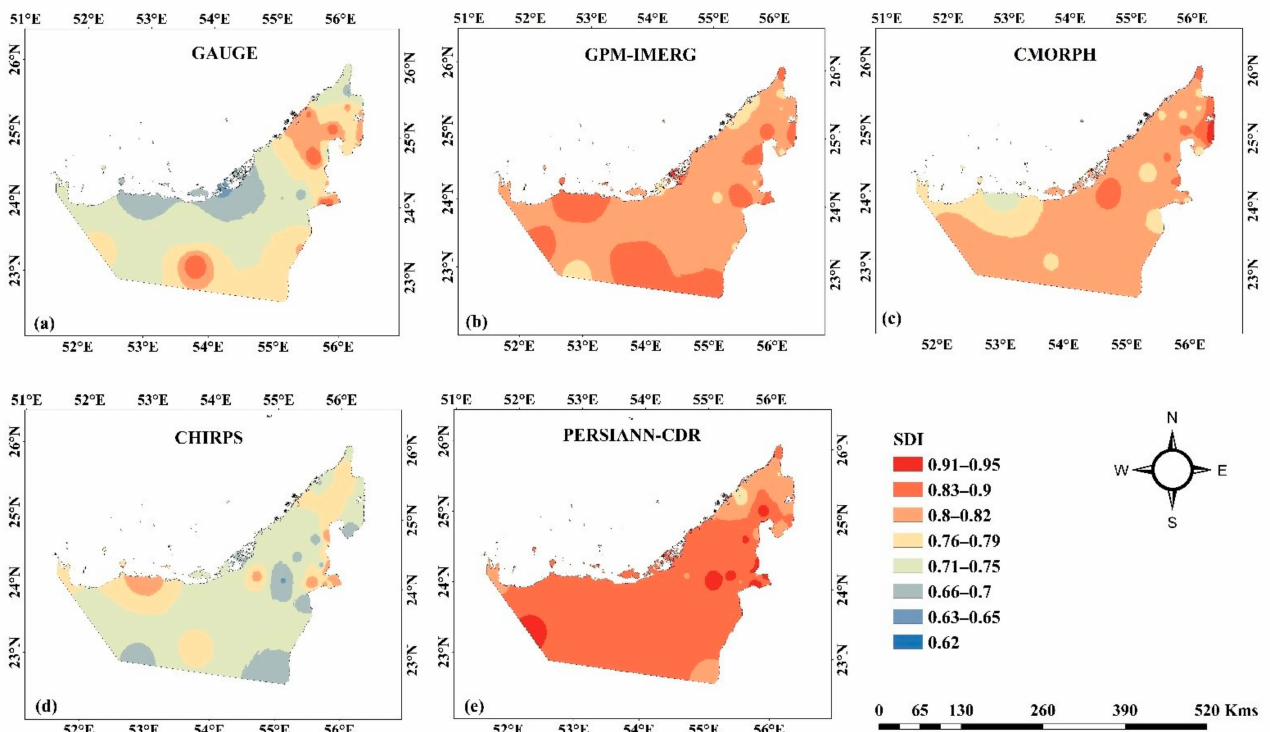
Figure 9. Precipitation variability distribution over UAE for the period of 2004–2020. Plots ( b – e ) represent the four satellite products while plot ( a ) shows the precipitation variability of rain gauge